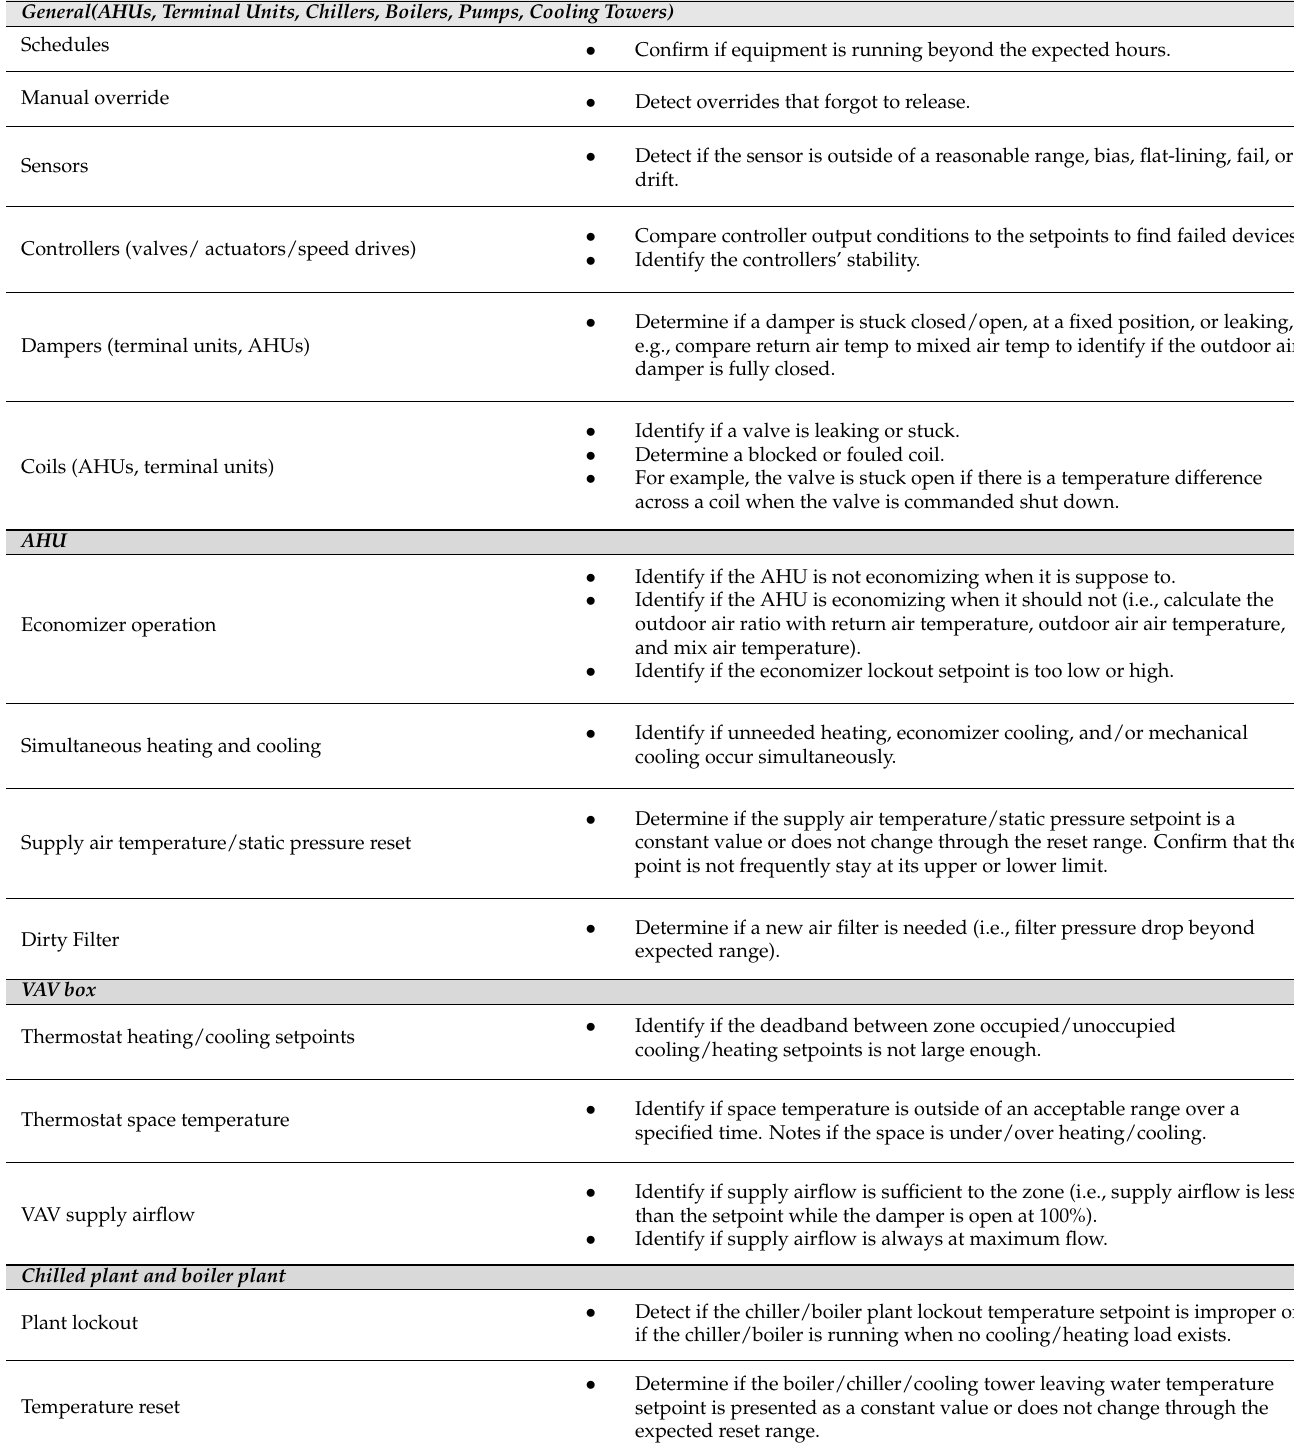
Table 7. Common faults or opportunities identified by FDD